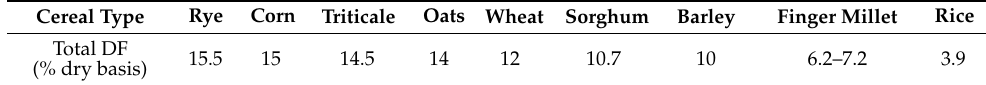
Table 1. Total dietary fiber content in cereal wholegrains